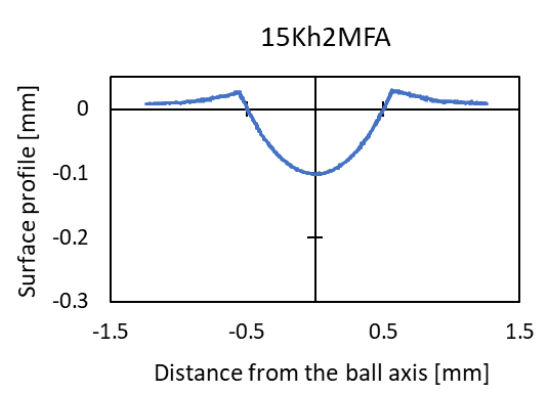
Figure 7. Cross-sectional profile of the spherical indent in 15Kh2MFA steel.